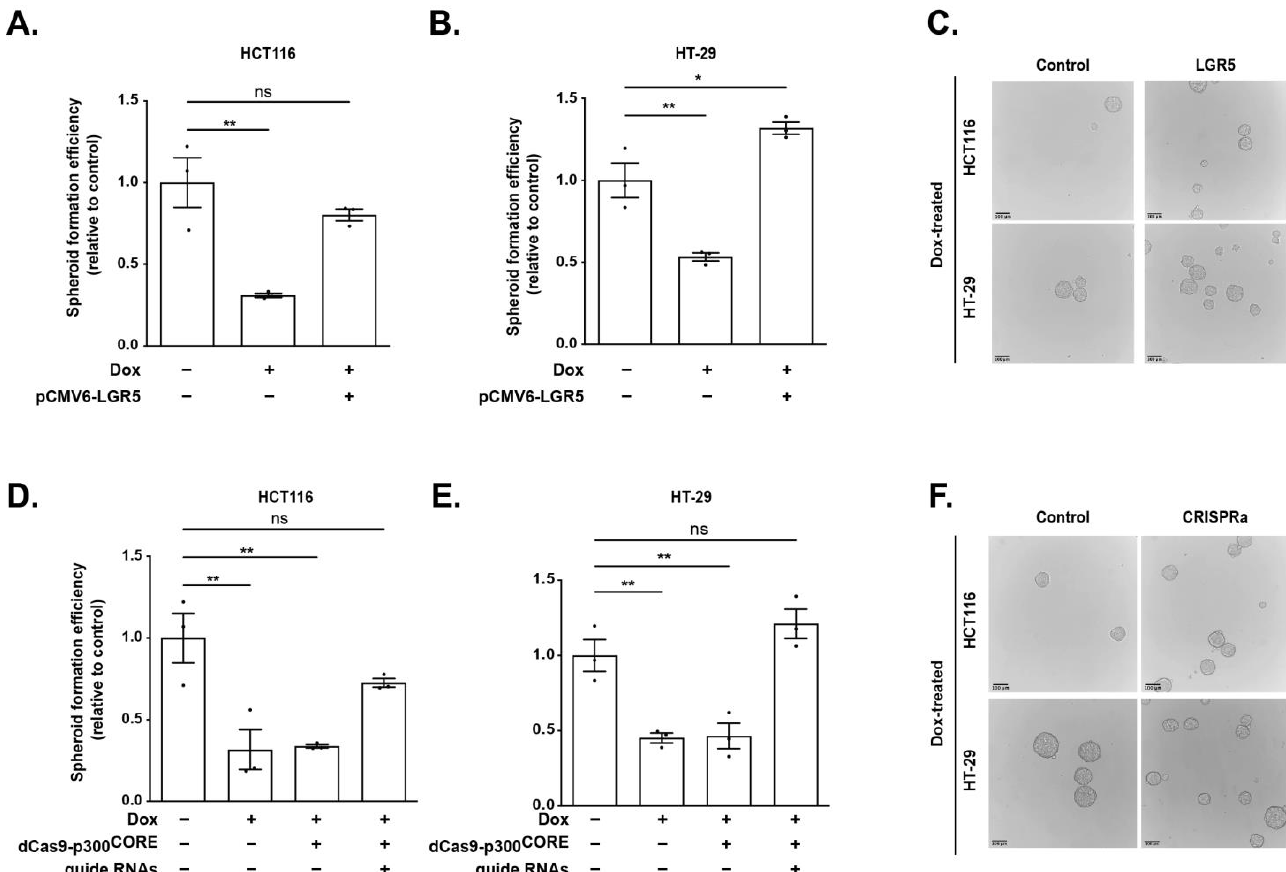
Figure 6. LGR5 expression rescues TCF7L1-mediated reduction in spheroid formation efficiency. ( A , B ) Spheroid formation efficiency and ( C ) representative images of spheroids formed from FLAG- TCF7L1 HCT116 and HT-29 cell lines that were transfected with a plasmid expressing LGR5 cDNA as indicated. ( D , E ) Spheroid formation efficiency and ( F ) representative images of spheroids formed from FLAG-TCF7L1-expressing cells that were co-transfected with plasmids expressing dCas9- p300 CORE ± guide RNAs as indicated. Scale bars are 100 µm. Data are normalized to spheroid formation efficiency of untreated HCT116 or HT-29, respectively, and represented as mean ± SEM (* p < 0.05, ** p < 0.01).